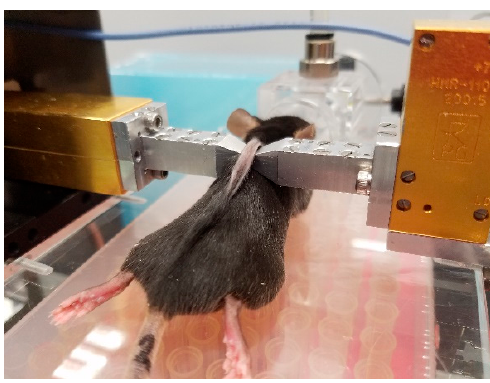
Figure 2. Photograph taken during the spectroscopic measurement.